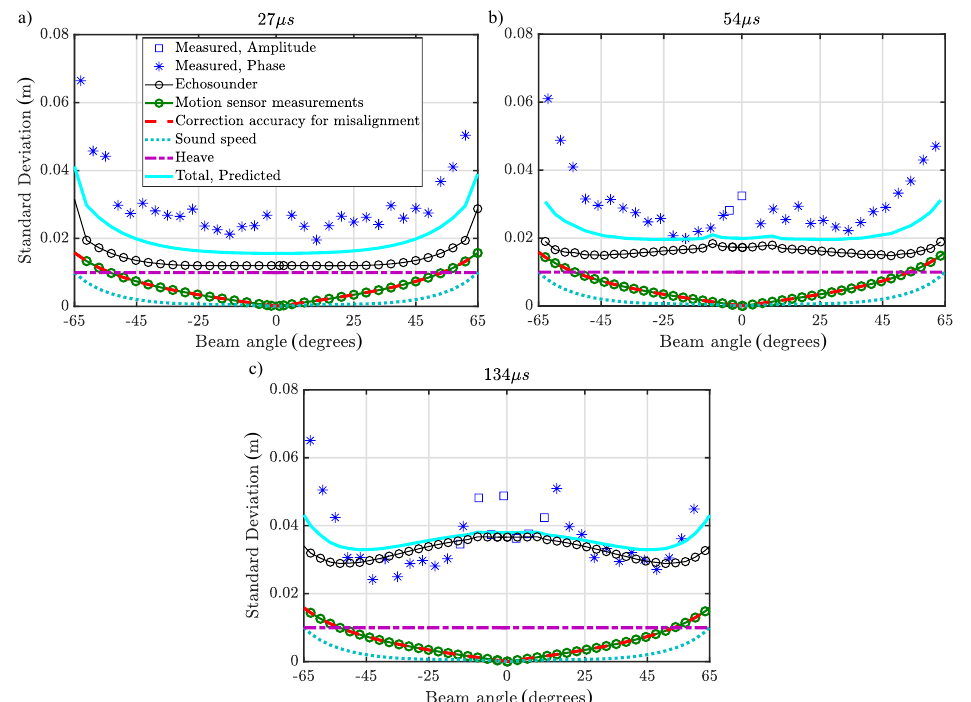
Figure 6. Bathymetric uncertainty derived from the measurements (blue) and those predicted for a water depth of 30m and a pulse length of ( a ) 27µs, ( b ) 54µs, and ( c ) 134µs. The change from amplitude to phase detection is shown by switching from square markers to asterisks with the same color. The location of this switch was similarly applied in the